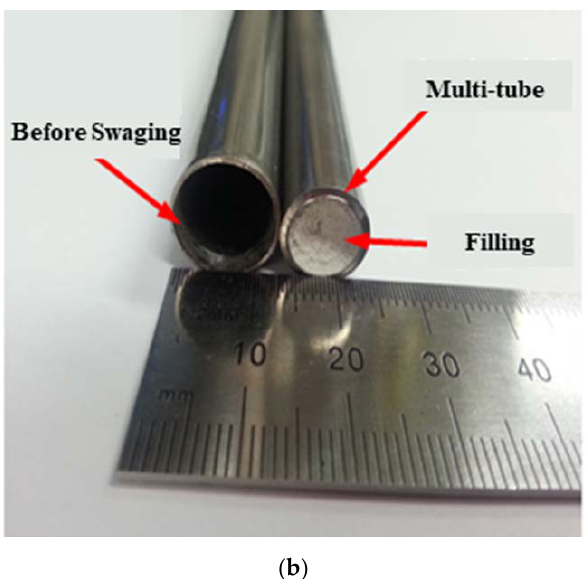
Figure 4. ( a ) Photographs of the final pseudo-single tube (PST), ( b ) Comparison of size change before and after swaging.